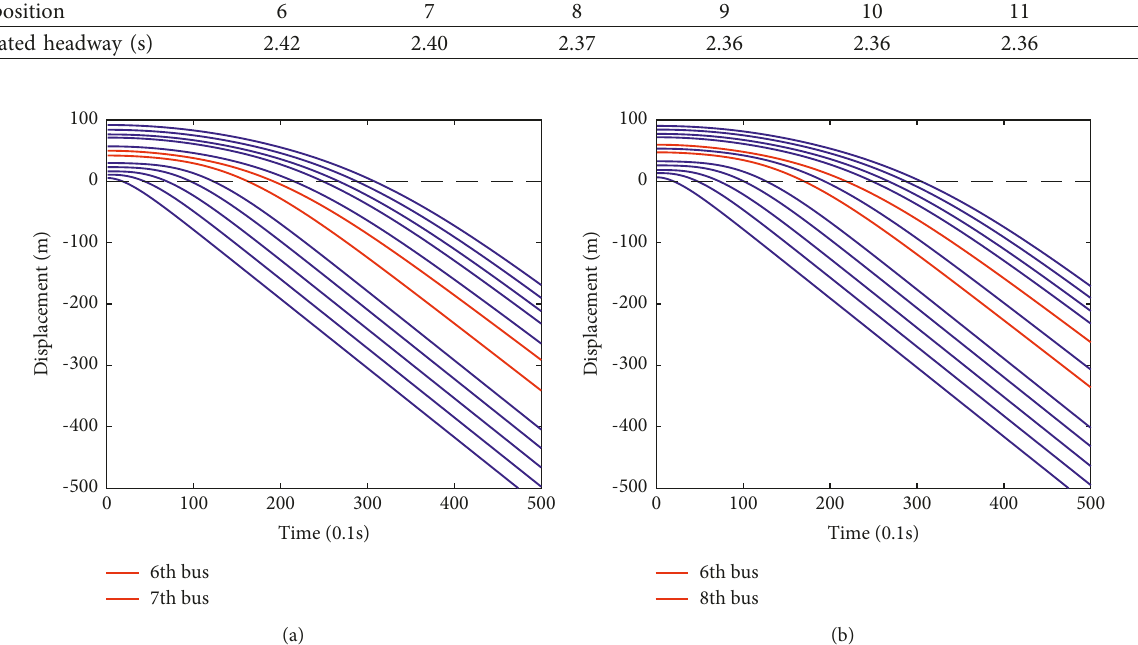
Table 4: The distribution of saturation headways with different positions of one bus in queue. Bus position 6 Saturated headway